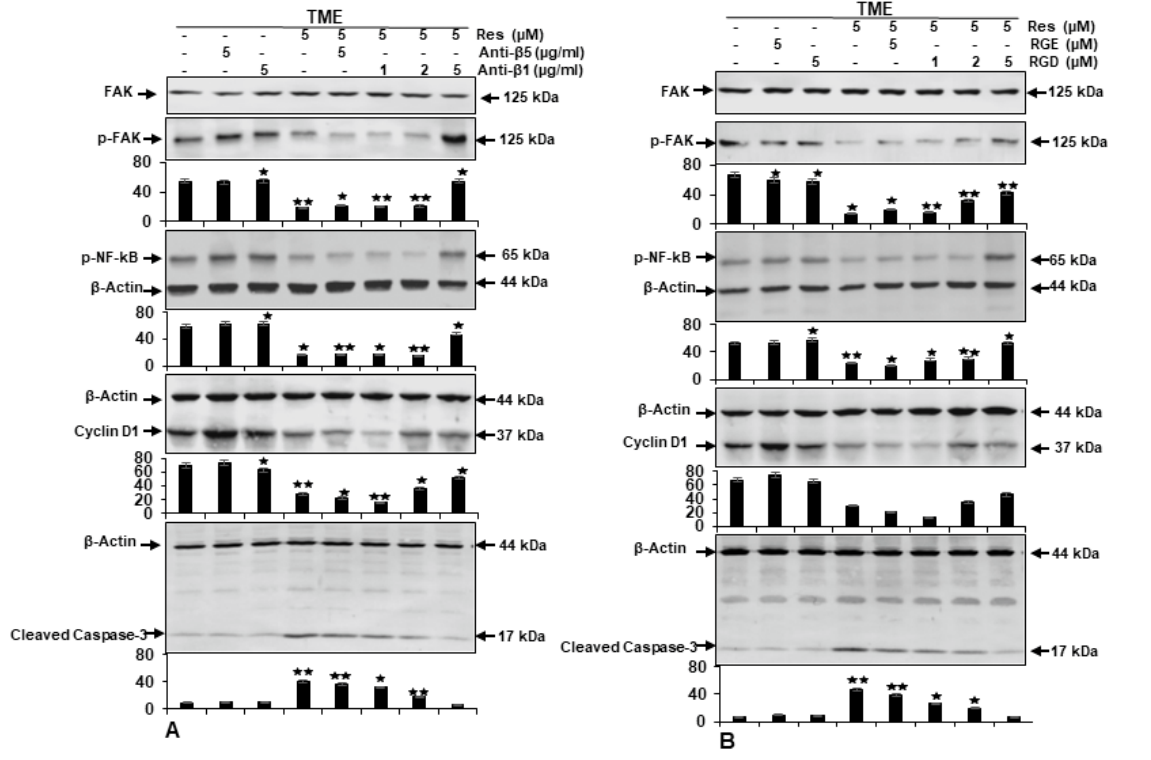
Figure 5. β 1-integrin is required for anti-tumor effects of resveratrol. TME-HCT116 cells were treated with resveratrol (5 µM) in the presence or absence of anti- β 1- (1, 2, 5 µg/mL), or anti- β 5- integrin (5 µg/mL) ( A ) or of RGD (1, 2, 5 µM), or RGE (5 µM) peptide ( B ) as mentioned in Materials and Methods. Western blot samples were probed with antibodies against FAK, p-FAK, p-NF-kB, cy- clin D1, and activated caspase-3. In addition, anti- β -actin was used as a loading control. Y -axis: densi- tometric units confirming Western blot results. * p < 0.05, ** p < 0.01 compared with TME control.